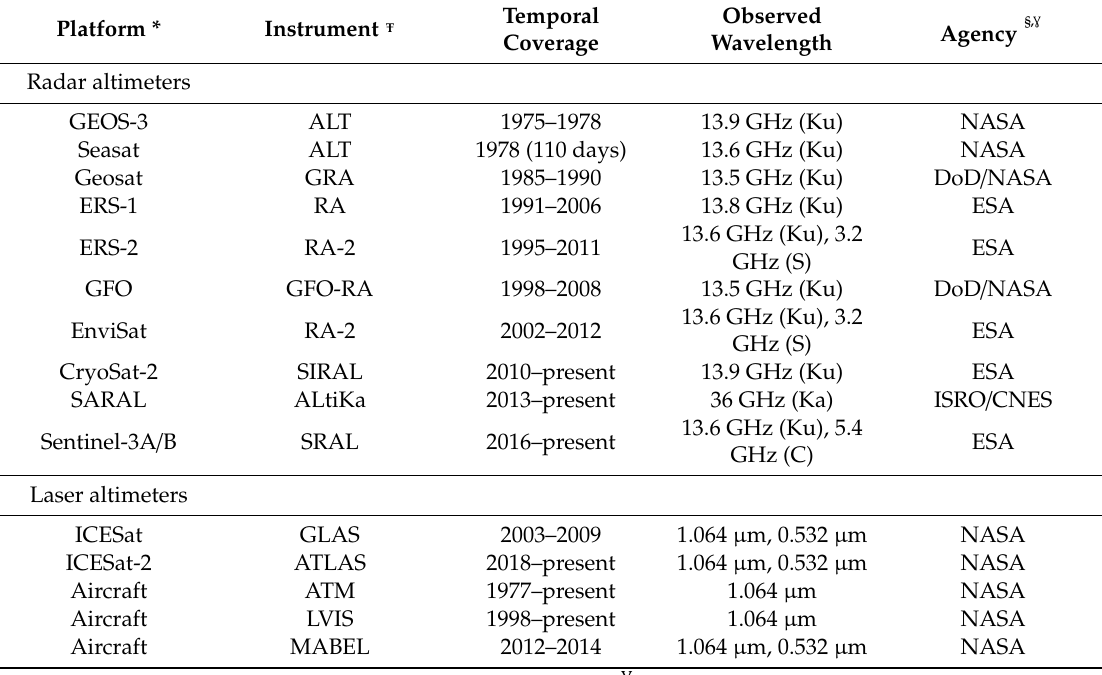
Table 1. Summary of radar and laser altimeter remote sensing platforms, instruments, temporal coverage, observed wavelength, and managing agencies.